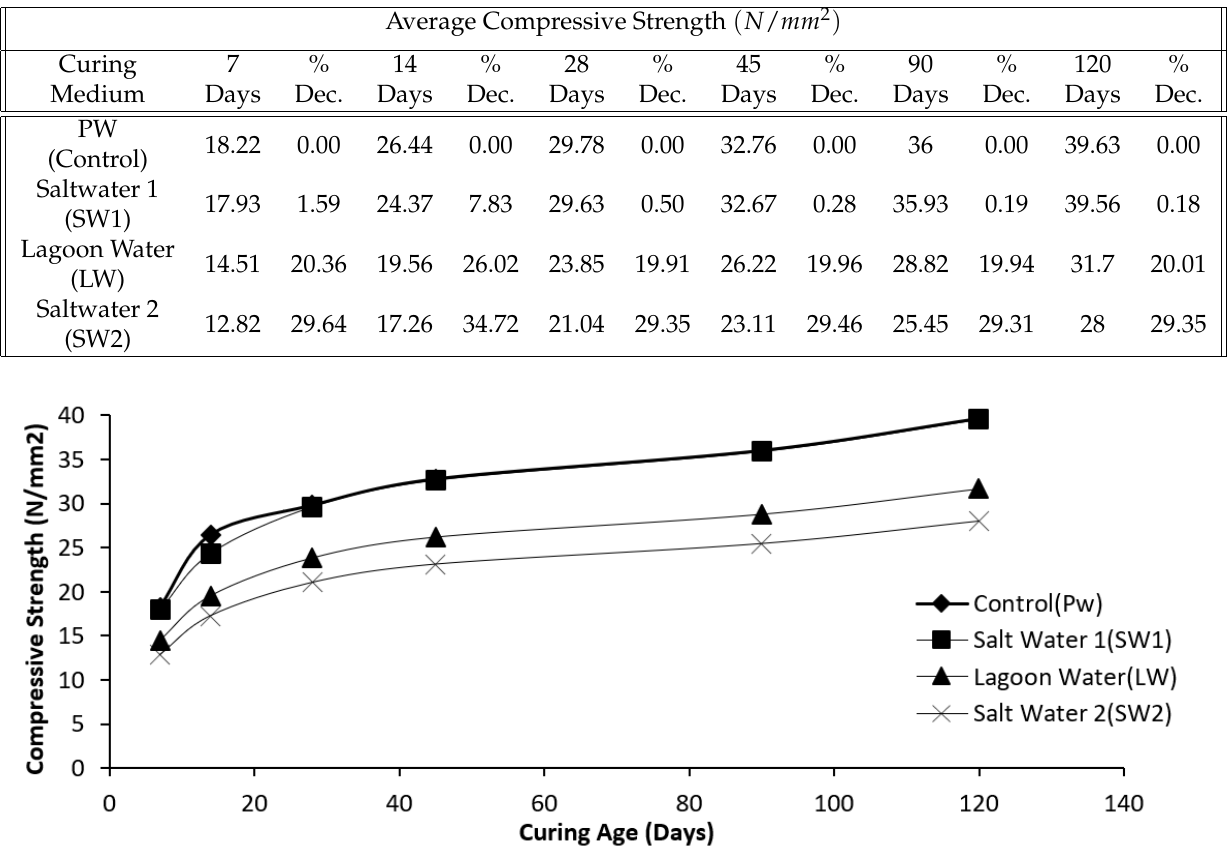
Figure 3. Effect of curing medium on the compressive strength of